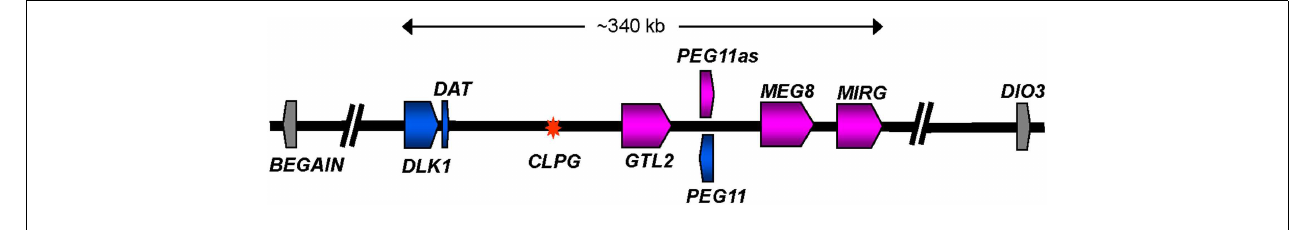
denotes the position of the Callipyge mutation ( CLPG ).The precise lengths of the maternally expressed genes, which all produce non-coding RNA, are unclear.The diagram is based on that deduced by (Georges et al., 2003) supplemented with annotation for a miRNA cluster ( MIRG ) deduced by comparative sequence analyses with orthologous murine and human sequence regions. A larger population of miRNA scattered throughout the core region has been omitted for clarity (Caiment et al.,